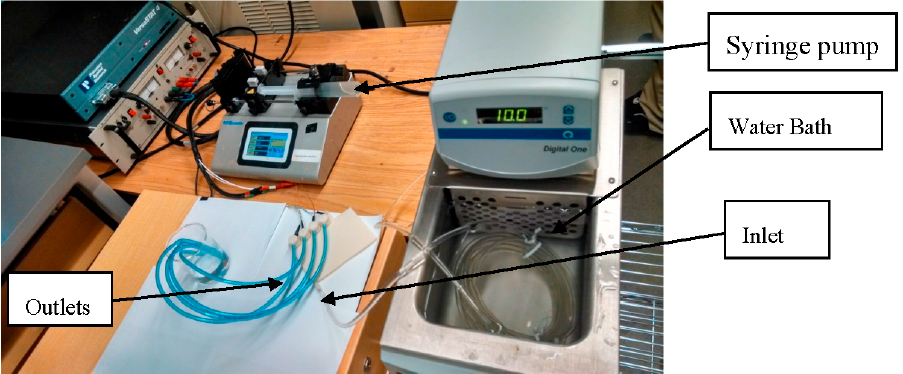
Figure A2. Experimental setup.